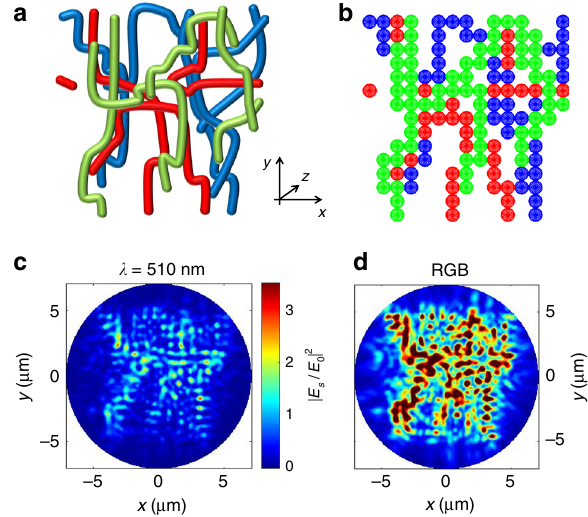
Fig. 3 Light back-scattering from three-dimensional fi ber non-wovens. a Scheme of the structure of nano fi bers used for the calculations. To mimic the morphological structure of the fi brous non-woven, an area of 10 × 10 µ m 2 is considered in the x – y plane, and three layers of fi bers are positioned along the axial ( z ) direction with total thickness 2.1 μ m (green nano fi bers are placed in the fi rst layer, red ones in the second layer, and blue ones in the third layer). The average fi ber diameter (700 nm) equals the value measured by SEM (Fig. S2, Supplementary Information). b Planar view ( x – y ) of cluster discretization used to calculate the light-scattering properties. Each polymer fi lament is schematized as a linear cluster with 700 nm spherical subunits. c Backscattering intensity map at λ = 510 nm, calculated as the ratio of the backscattered fi eld ( E s ) and the incident one ( E 0 ). The map is obtained by considering a plane wave illumination with unitary amplitude impinging perpendicularly to the fi bers (i.e., along the z axis), averaging over polarization, and it is calculated at about 1 μ m distance from the fi rst layer of the structure. d RGB intensity map obtained as the sum of the backscattering maps calculated at wavelengths corresponding to red ( λ = 600 nm), green (530 nm,) and blue (450 nm) represent fi laments in the fi rst, second, and third layer, respectively. The backscattering intensity map at λ = 510 nm (given by the squared ratio of the backscattered and the incident fi eld, | E 2 ) is obtained by considering a plane-wave illumina- s / E 0 | tion with unitary amplitude impinging perpendicularly to the structure (i.e., along the z direction), averaging over polarization, and it is calculated at ∼ 1 μ m distance from the fi rst layer of the structure (Fig. 3c). A critically important parameter that yields quantitative information on the amount of the backscattered light is the albedo value, A = C scat / C ext , de fi ned as the ratio of the scattering, C scat , and extinction, C ext , light-scattering cross- sections. T-matrix calculations yield an albedo of about A 510 = 0.73 at λ = 510 nm, which is one order of magnitude higher than